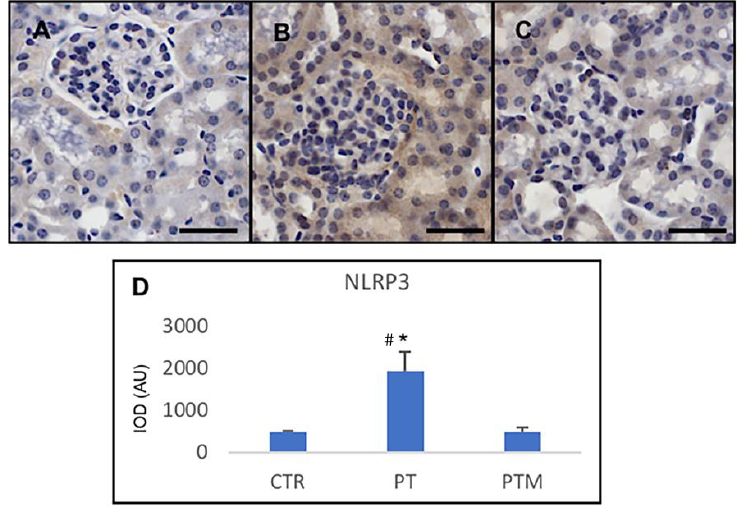
Figure 6. Photomicrographs showing transforming NLRP3 immunohistochemistry of control mice ( A ), pristane-LN mice ( B ) and pristane-LN mice treated with melatonin ( C ). Bar equals 20 μm. The graph ( D ) summarizes NLRP3 immunohistomorphometrical analysis of all experimental groups. *# indicate respectively statistically significant differences vs control and pristane-LN mice treated with melatonin: * p < 0.05. CTR: control mice PT: pristane-LN mice PTM: pristane-LN mice treated with melatonin.